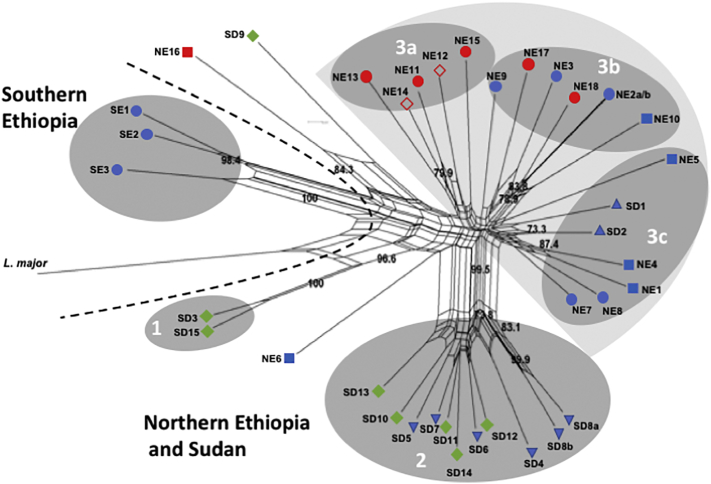
Neighbor-net splits graph derived from combined analysis of AFLP using six selective primers. Results were analyzed using optiFLP (Arthofer et al., 2011) and tinyFLP (Arthofer, 2010), and the binary matrices concatenated using tinyCAT (Arthofer, 2010). The tree above was built using Neighbor-net analysis of the concatenated binary matrix with Splitstree 4 (Huson and Bryant, 2006). The numbers above each branch indicate the bootstrap support in percentage from 1000 replicates. SD1 and SD2 are reference strains from Sudan that were isolated in 1943 and 1962, respectively. Strains NE2a and NE2b, as well as SD8a and SD8b, are technical duplicates. Selective PCRs for these strains were run in duplicate using the same pre-selective PCR product. Strain origin: Northern Ethiopia (NE) groups 3a, 3b and 3c, Southern Ethiopia (SE) group1, and Sudan (SD) groups 2 and 3c. Clinical presentation: VL – blue, HIV/VL co-infection – red, PKDL – green. Tissue source: skin isolates – both full and empty diamonds, spleen isolates - circles, lymph node -inverted triangle, bone marrow isolates - squares, and no information - pyramid. Leishmania major was included as an outlier. (For interpretation of the references to colour in this figure legend, the reader is referred to the web version of this article.)